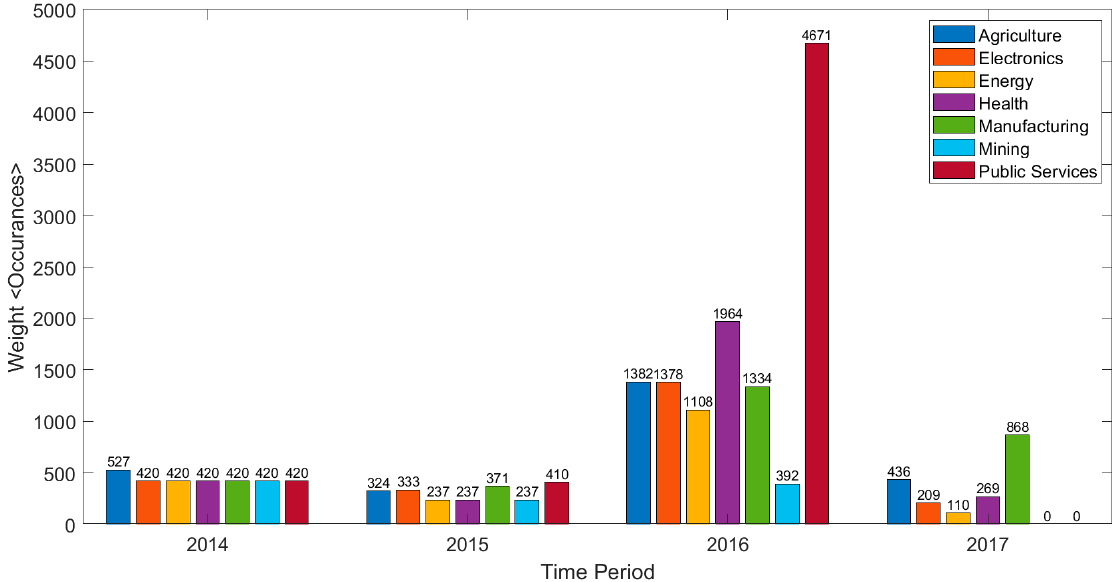
Figure 1. Trends of Industry Impacted by Internet of Things (IoT). Adapted from [5].